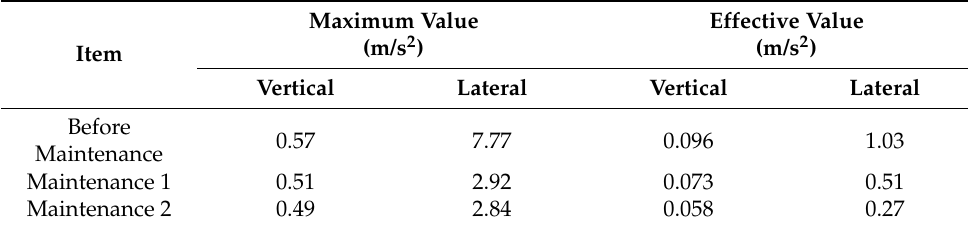
Table 3. Statistical values of the acceleration of pantograph strip.